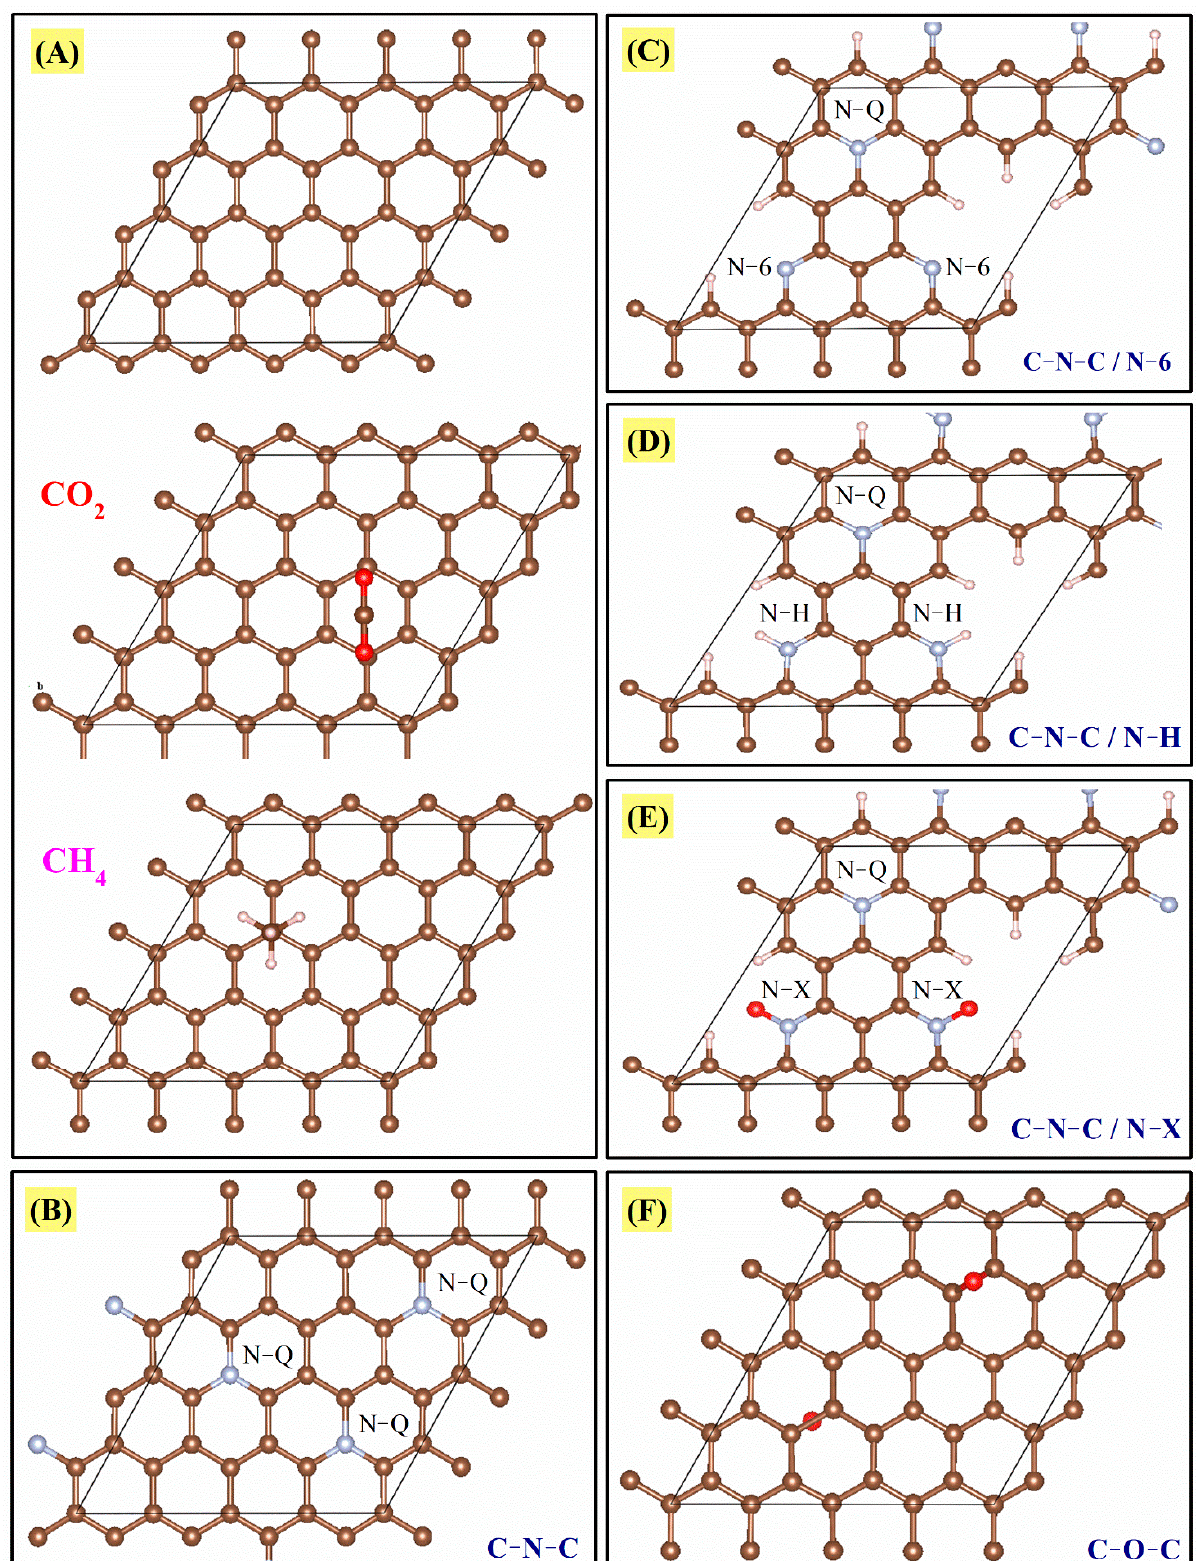
Figure 11. Panel with the configurations proposed for the physisorption of CO 2 and CH 4 molecules on the carbon sheet and its different functional groups, ( A ) C=C, ( B ) C-N-C, ( C ) C-N-C and N-6, ( D ) C-N-C and N-H, ( E ) C-N-C and N-X, and ( F ) C-O-C.